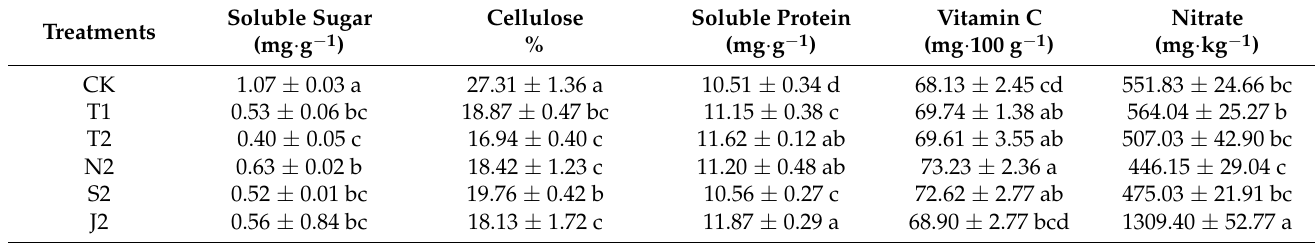
Table 3. Effects of bio-organic fertilizer with 20% nitrogen reduction on quality of non-heading Chinese cabbage.